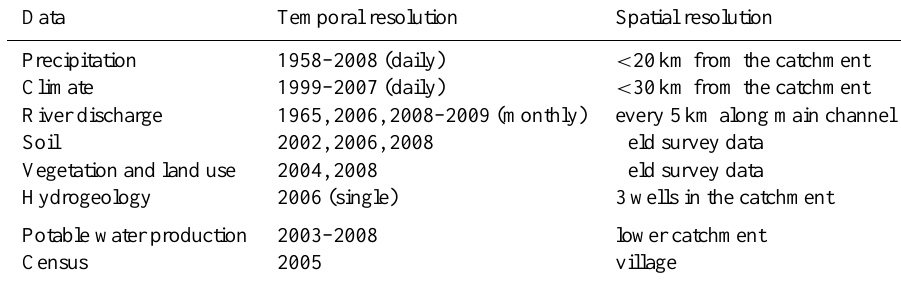
Table 1. Geophysical and socio-economic data base.